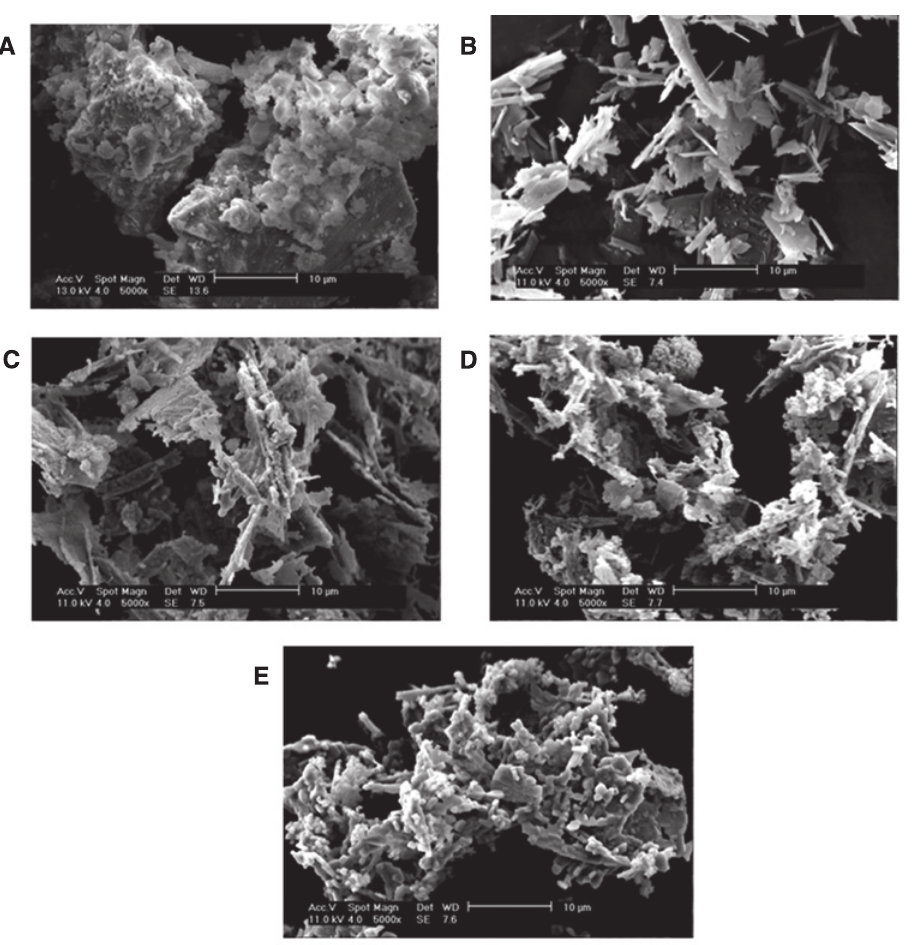
Figure 5: SEM micrographs of samples at magnifications of 5000 times: (A) duck eggshell powder; (B) calcium sulfate hemihydrate (CaSO · 0.5H O) powder before firing; (C) calcium sulfate hemihydrate powder calcined at 700 ° C; (D) calcium sulfate hemihydrate powder 4 2 calcined at 800 ° C; and (E) calcium sulfate hemihydrate powder calcined at 900 °